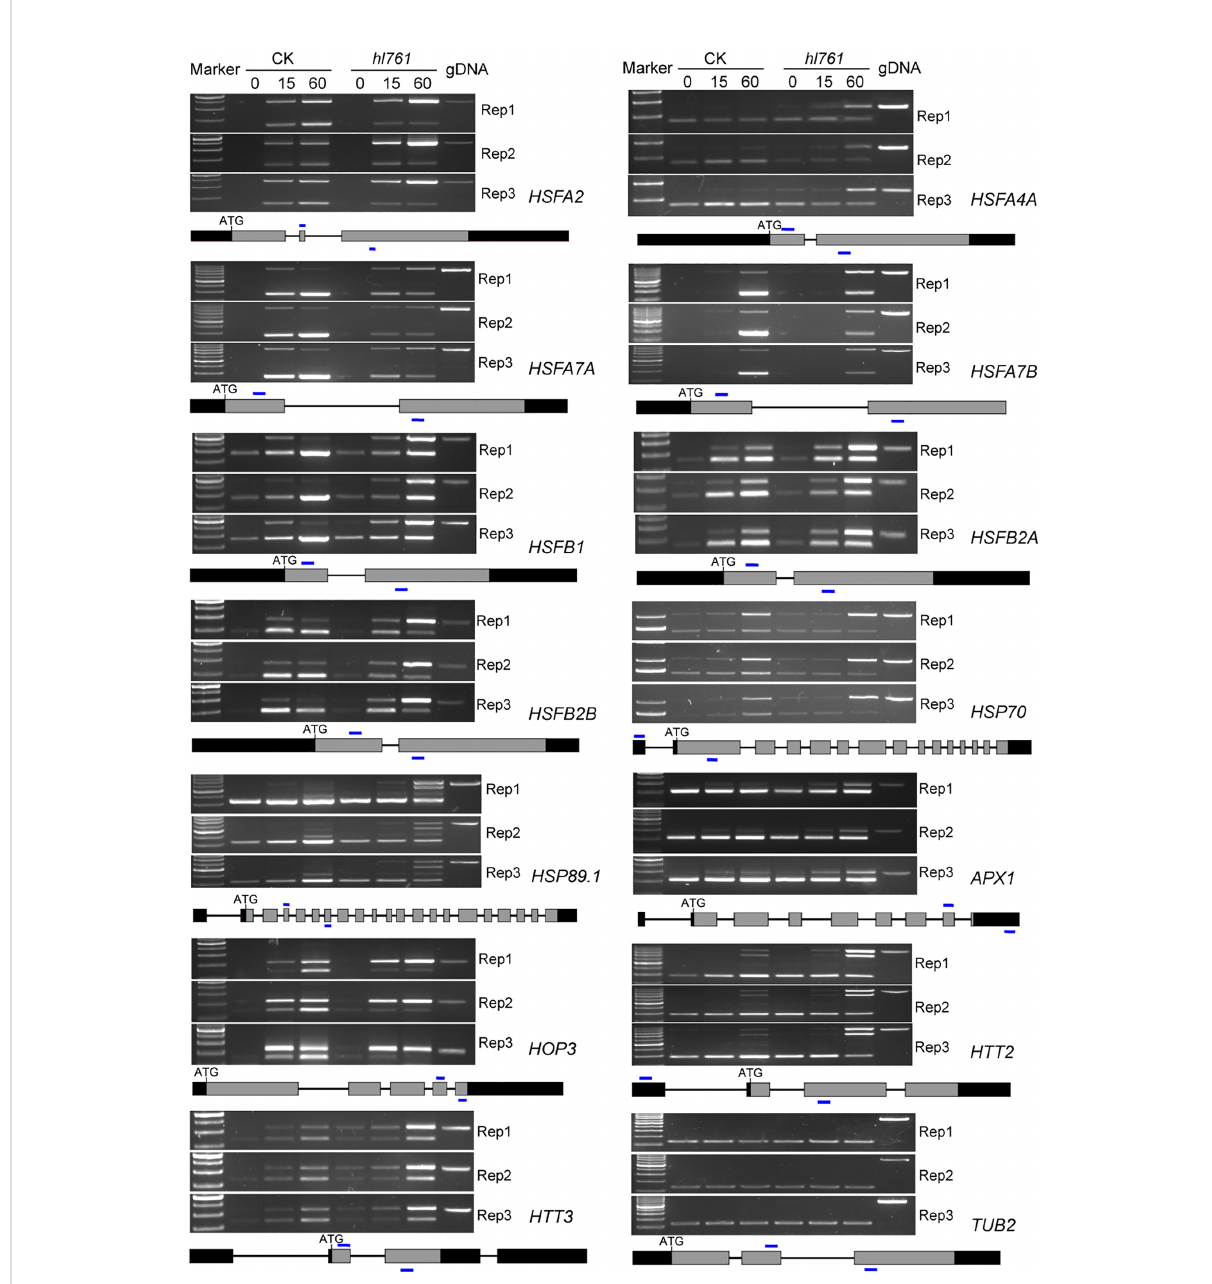
FIGURE 8 NTR1 mutation alters the AS of HSF s and HSP s under heat stress. Three biological repeats are presented. Below the gel pictures are the schematic of the gene structure. Gray boxes indicate the exons, black boxes indicate the 5 ′ or 3 ′ -UTR, lines in between indicate the introns, and blue lines show the primer position for RT-PCR. CK, background line for hl761 ; AS, alternative